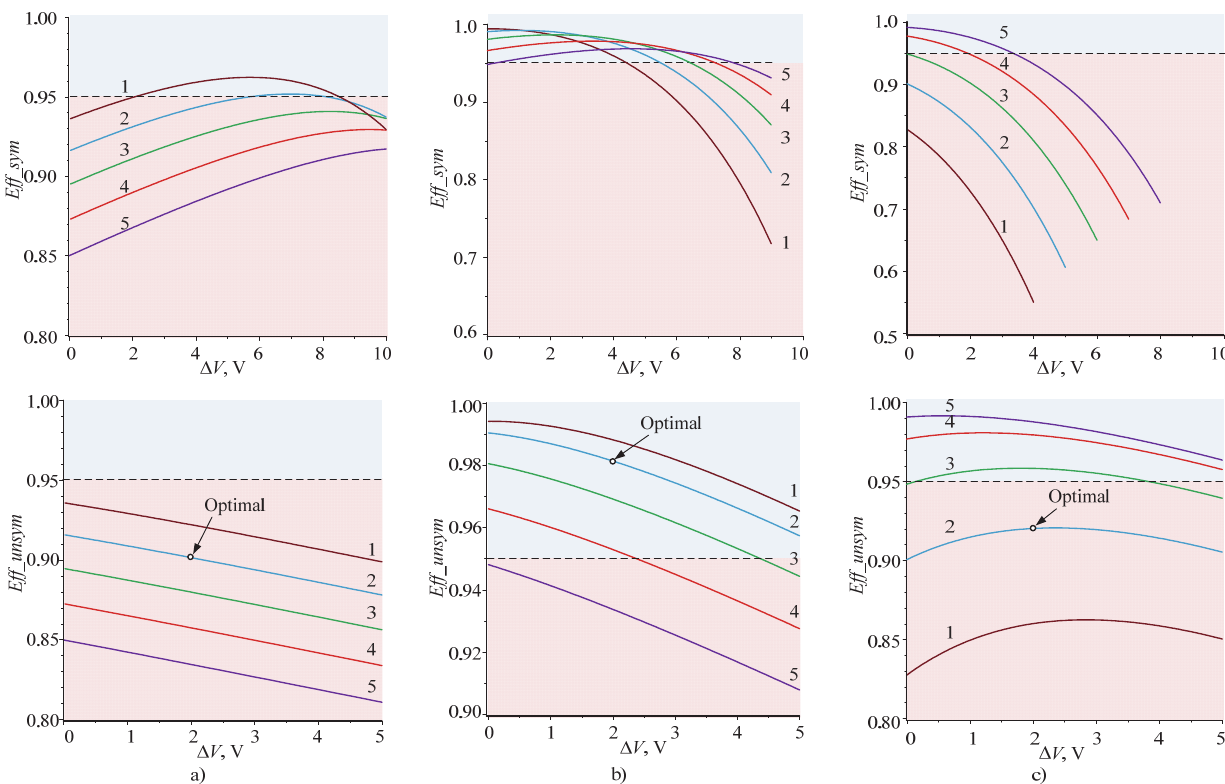
Fig. 7. Efficiency of the optimizer for different V mdl : 1 – 19.5 V, 2 – 19.0 V, 3 – 18.5 V, 4 – 18.0 V, 5 – 17.5 V: T = 0 °C (a), T = 25 °C (b), T = 50 °C